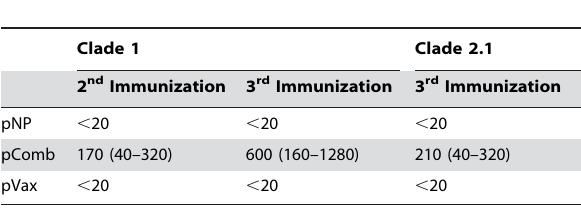
Table 1. Hemagglutination Inhibition of H5N1 Influenza